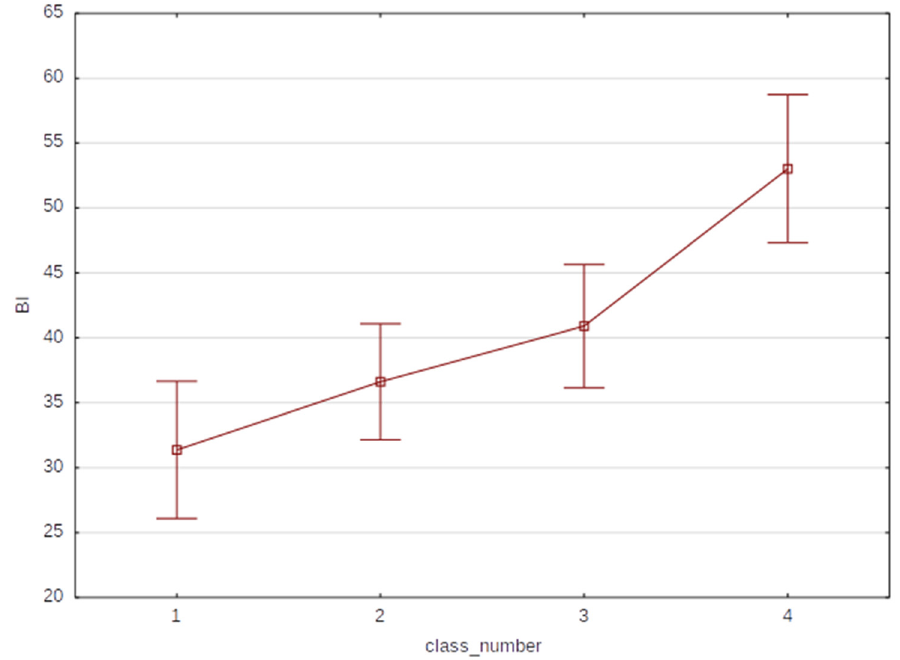
Figure 4. Mean values and 0.95 confidence intervals for the BI coefficient for samples belonging to classes 1–4, which corresponded to drying temperatures of 60, 70, 80, and 90 °C.